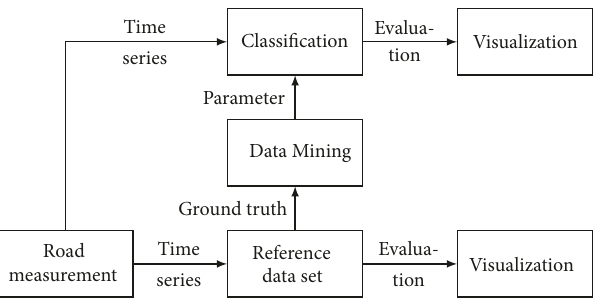
Figure 1: Overview of